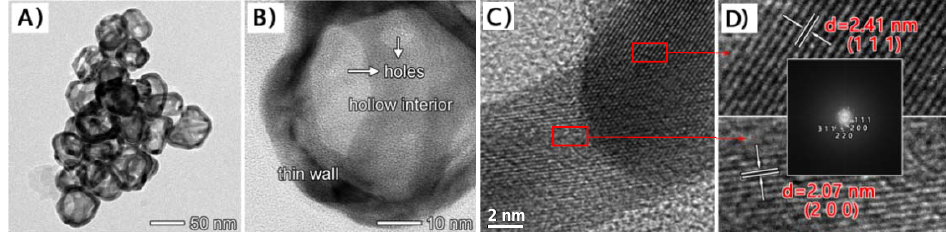
Figure 1. ( A ) Regular TEM image; ( B , C ) HRTEM image of an individual AuNC; ( D ) HRTEM under amplification (insert is fast-Fourier transform electron diffraction pattern).